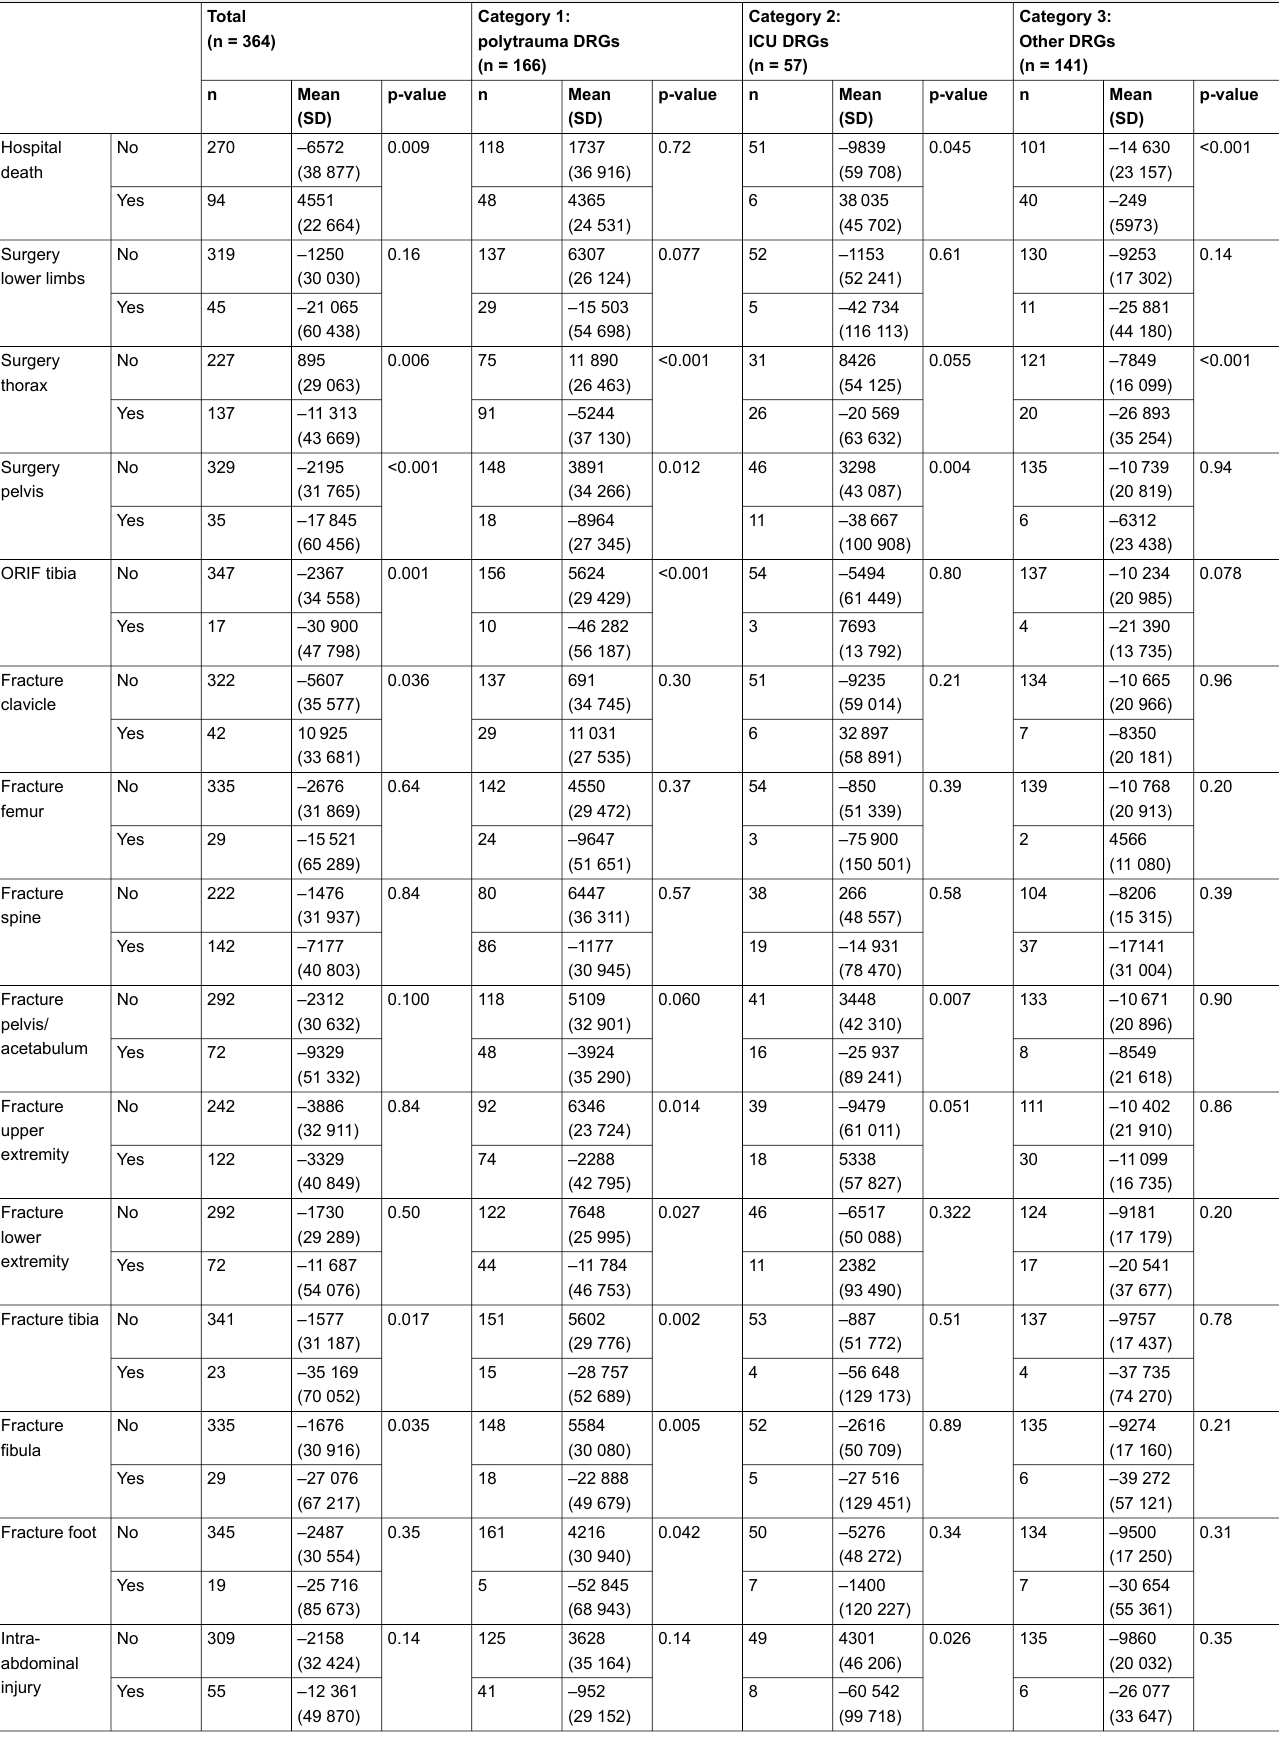
Table S4: Univariate analysis of association of predictive factors with average profit/deficit per DRG category for nominal variables. Profit/deficit based on case weights from SwissDRG catalogue version 3.0, including supplemental payments, given as mean (standard deviation). Association was analysed with the Mann-Whitney